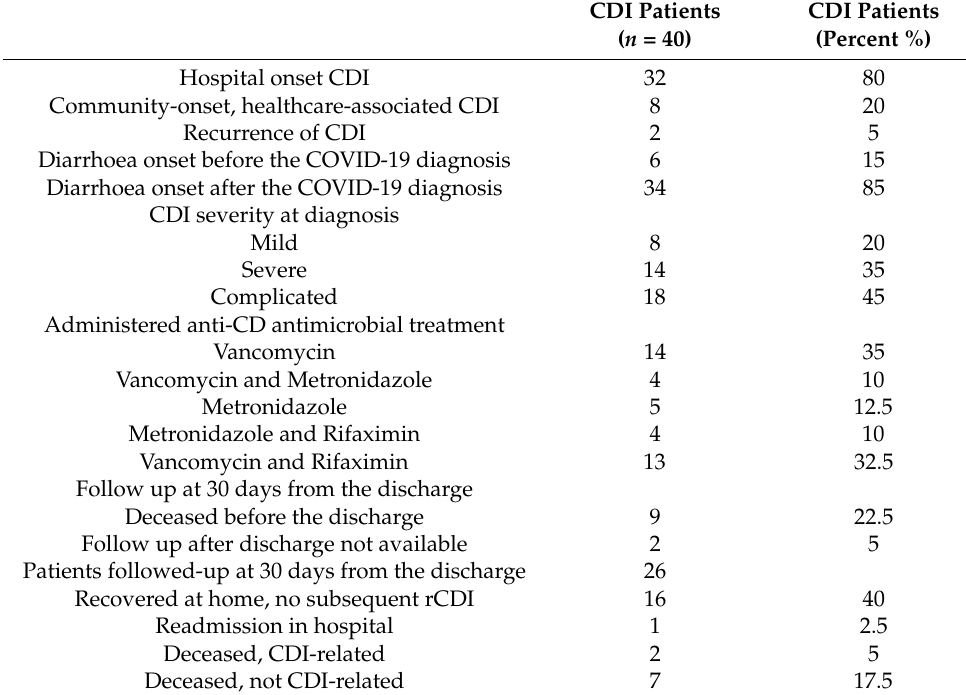
Table 2. CDI characteristics, severity, management, outcome, and 30 days follow-up of the 40 COVID-19 patients with